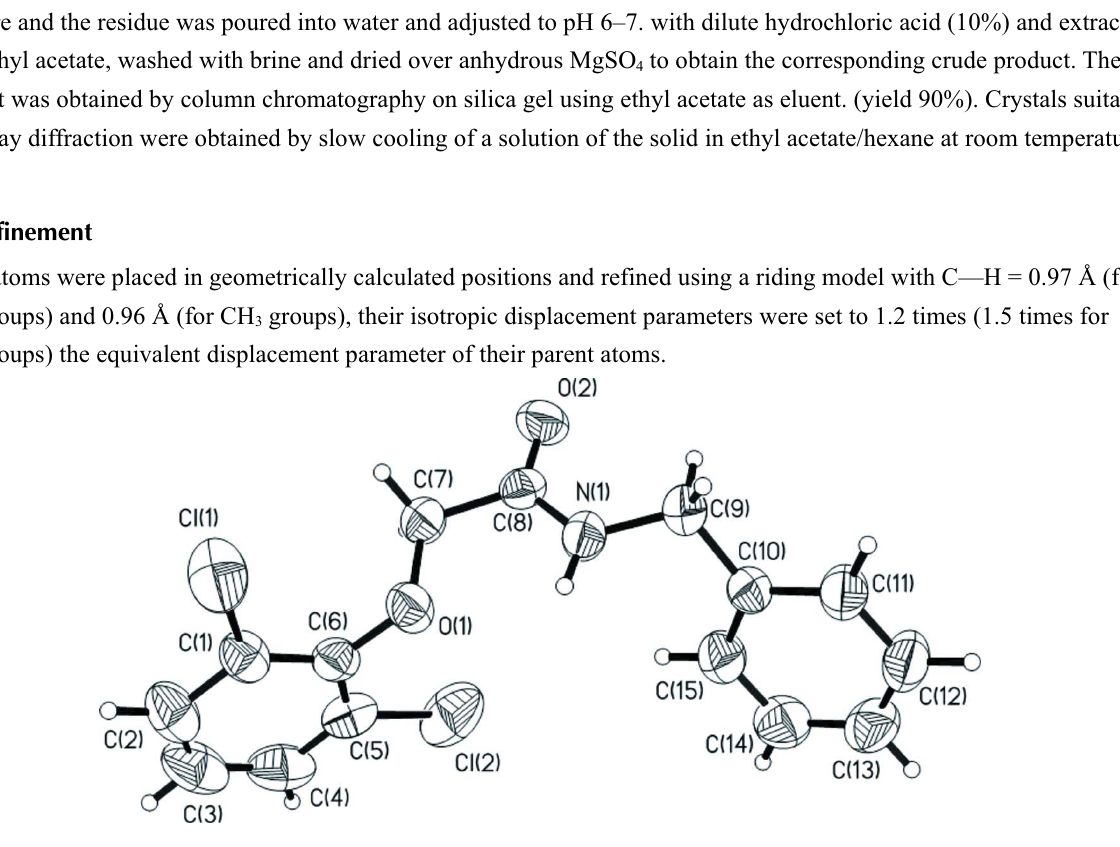
The molecular structure of the title compound with labelling and displacement ellipsoids drawn at the 50% probability